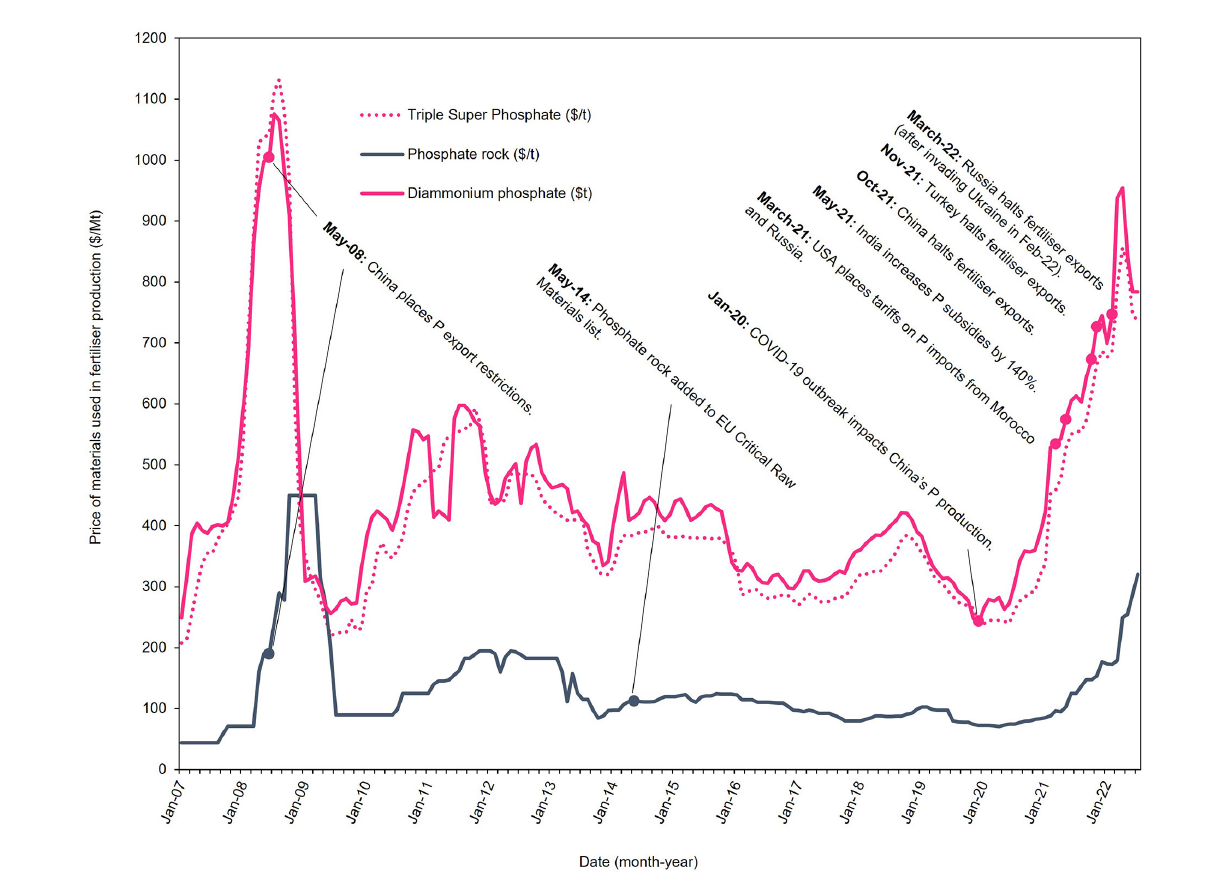
FIGURE1 The monthly price, January 2007 to June 2022, of phosphorus (P) commodities used in fertilizer production (US$ ton − 1 ): triple super phosphate, diammonium phosphate and phosphate rock. The price of phosphorus peaked in 2008 and increased sharply again in 2021. Key national responses impacting the trade of phosphorus and fertilizer are shown. Data Source: The World Bank